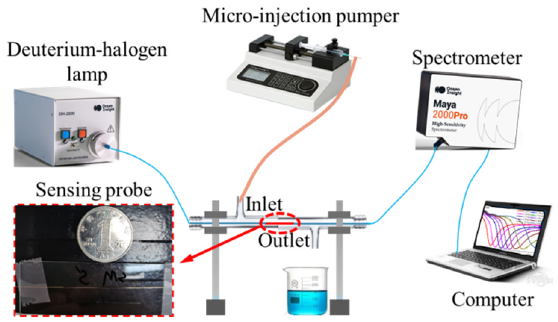
Figure 5. Schematic of the experimental setup.